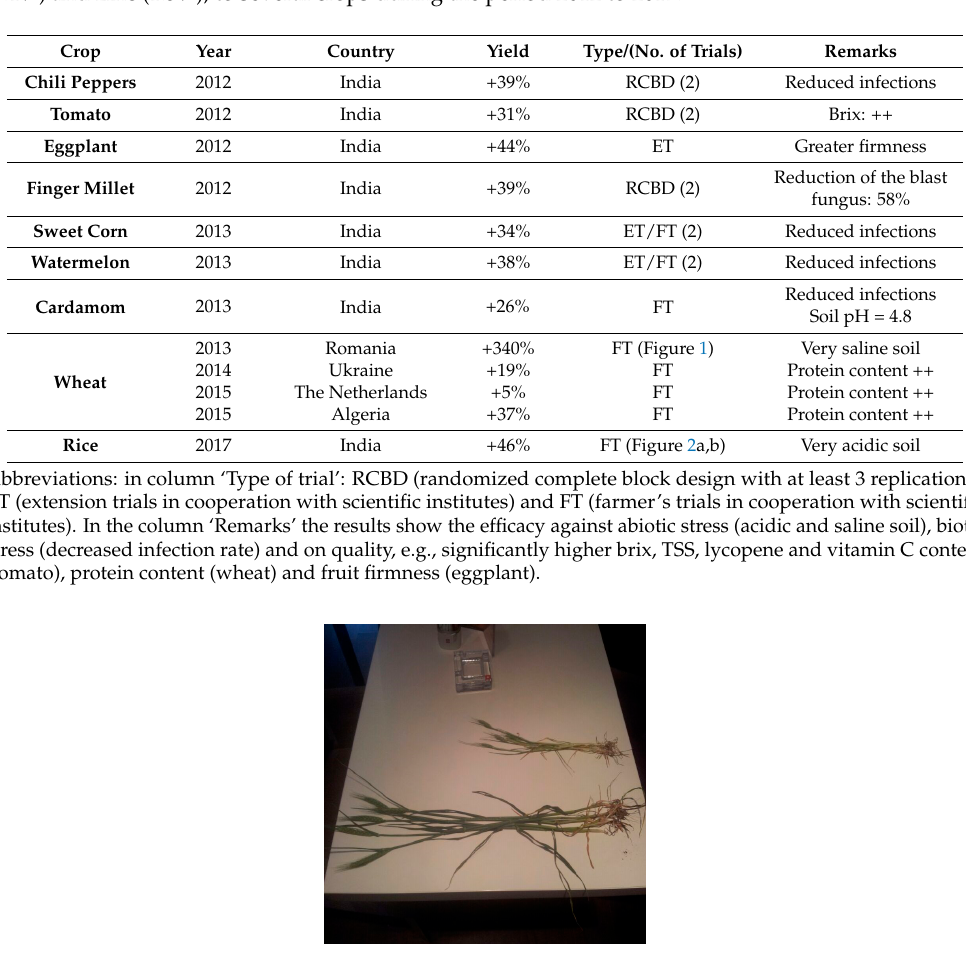
Figure 1. The effects of foliar application of PEG-sSA on wheat grown in very saline soil (area of 3 ha) in Romania during 2014. Half of the plot was sprayed four times with AB Yellow ® (=4 mL/L PEG-sSA plus B, Mo and Zn). The visual differences between the sprayed plants (taller plants) and the control (small plants) can be seen.